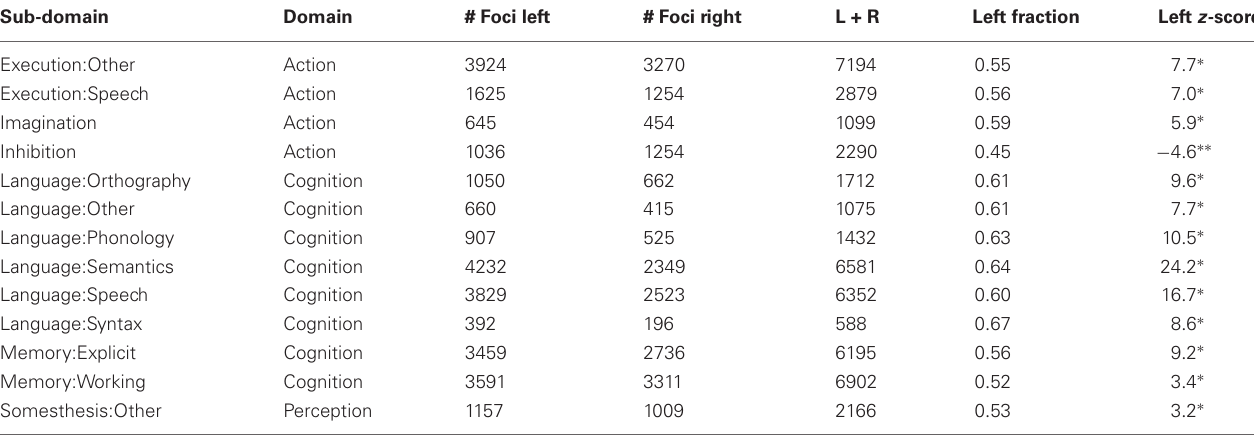
Table 3 | Left-Right distribution of activation foci by behavior sub-domain.